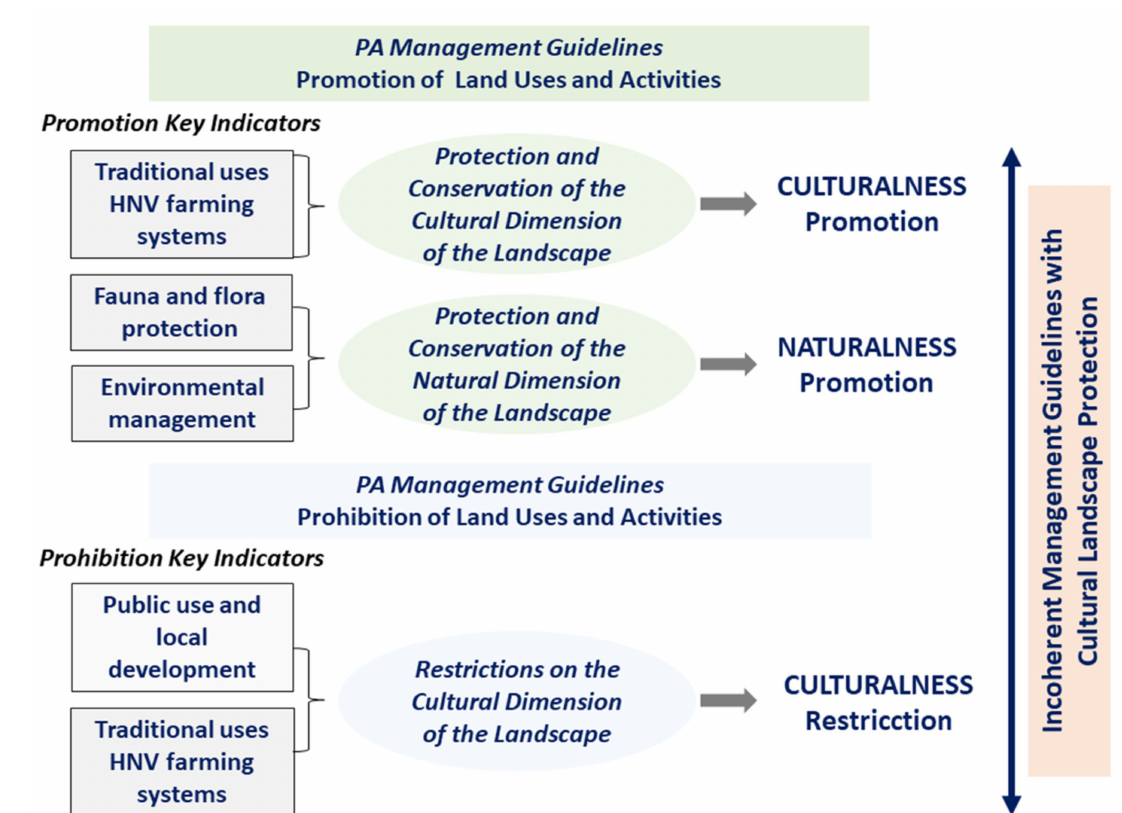
Figure 1. General outline of the main indicators of the PA management guidelines, identified from the analysis of the corresponding normative documents. Modified from Sarmiento-Mateos et al. 2019